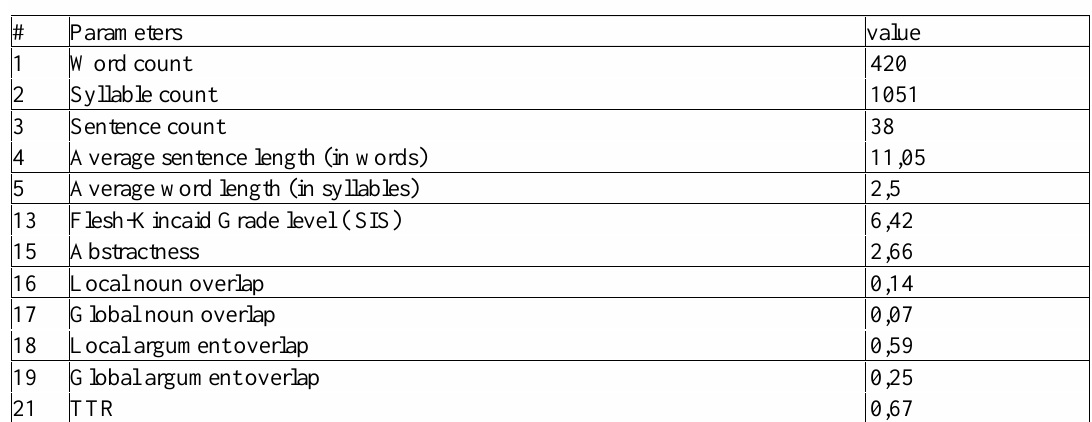
Table 1. Text readability parameters measured with